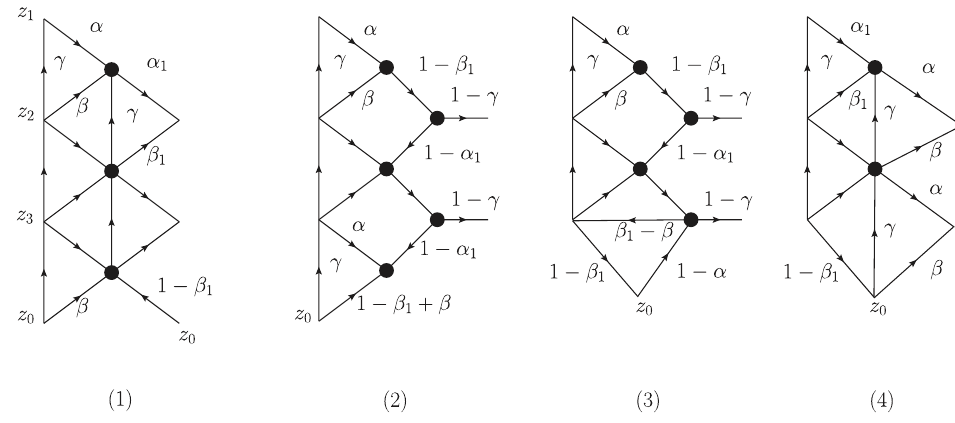
Figure 6 . The proof of diagonalization procedure for the operator (cid:3) N ( y z 0 ) for N = 3, pushing j the operator through the (cid:12)rst row of the eigenfunction: (1) The diagram for (cid:3) 3 ( y z 0 ) ~(cid:3) 2 ( x 1 ): j (cid:11) = 1 s y , (cid:11) 1 = 1 s x 1 , (cid:12) = 1 s + y , (cid:12) 1 = 1 s + x 1 , (cid:13) = 2 s 1. (2) Star-triangle (cid:0) (cid:0) (cid:0) (cid:0) (cid:0) (cid:0) (cid:0) transformations inside ~(cid:3) 2 ( x 1 ) and two lines (cid:12) and 1 (cid:12) 1 ending at z 0 joint to the one line (3) (cid:0) Movement of the line with index (cid:12) 1 (cid:12) upstairs using cross relations leads to ~(cid:3) 2 ( x 1 ) (cid:3) 2 ( y z 0 ), (cid:0) j